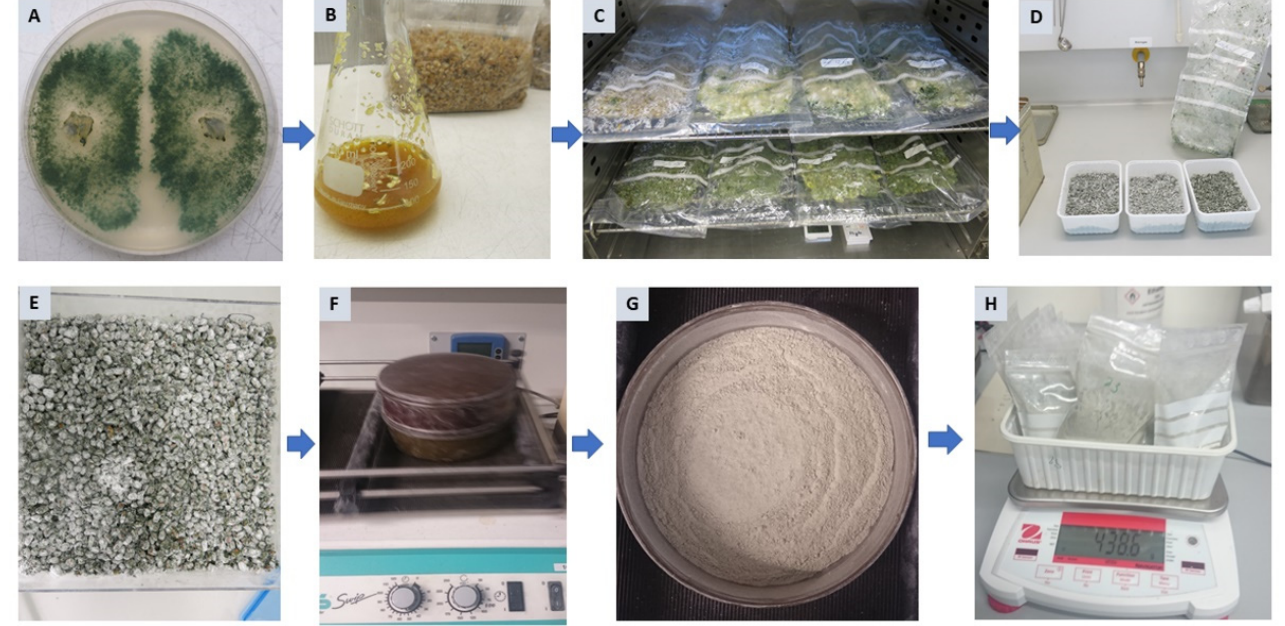
Figure 6. The various stages of production of Trichoderma formulations: ( A ) Trichoderma mother culture on PDA; ( B ) Starter culture production and inoculation of substrates; ( C ) Incubation of different substrates; ( D ) Drying after mixing with talcum; ( E ) Dried substrates; ( F ) Spores harvest by sieving; ( G ) Product collection; ( H ) Product packaging.